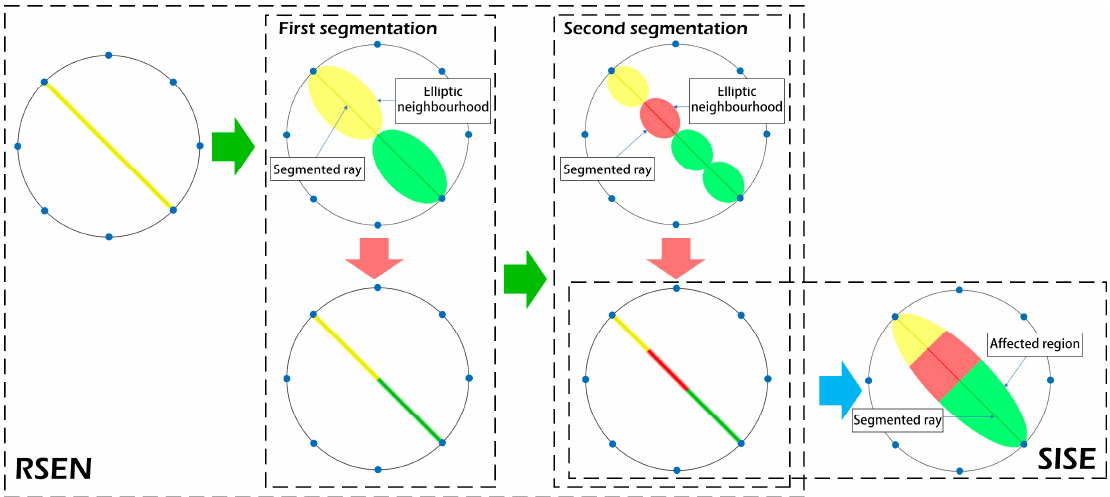
Figure 2. Illustration of the proposed method. RSEN (ray segmentation by elliptical neighborhood), SISE (spatial interpolation by segmented ellipse). Appl. Sci. 2018 , 8 , x FOR PEER REVIEW